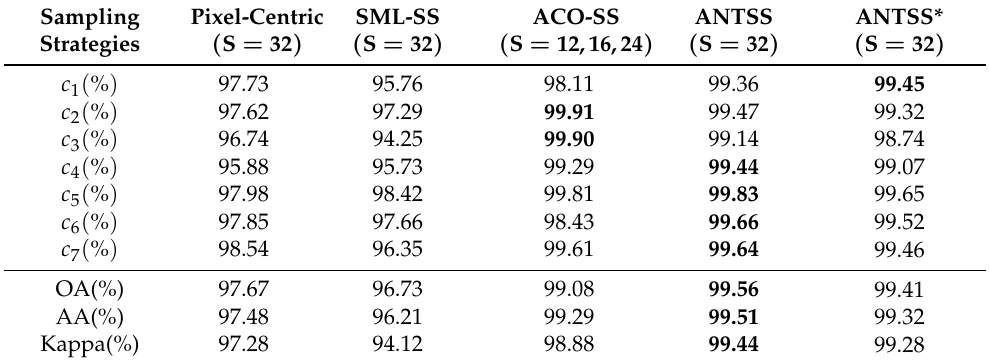
Table 2. Quantitative comparison over different sampling strategies on the Xi’an Urban image data. Sampling Strategies